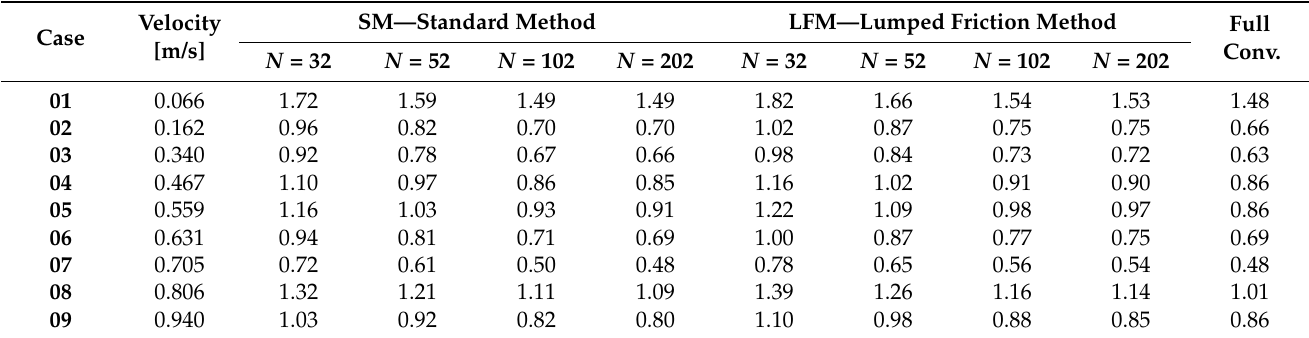
Table 3. Quantitative results of the Et coefficients.